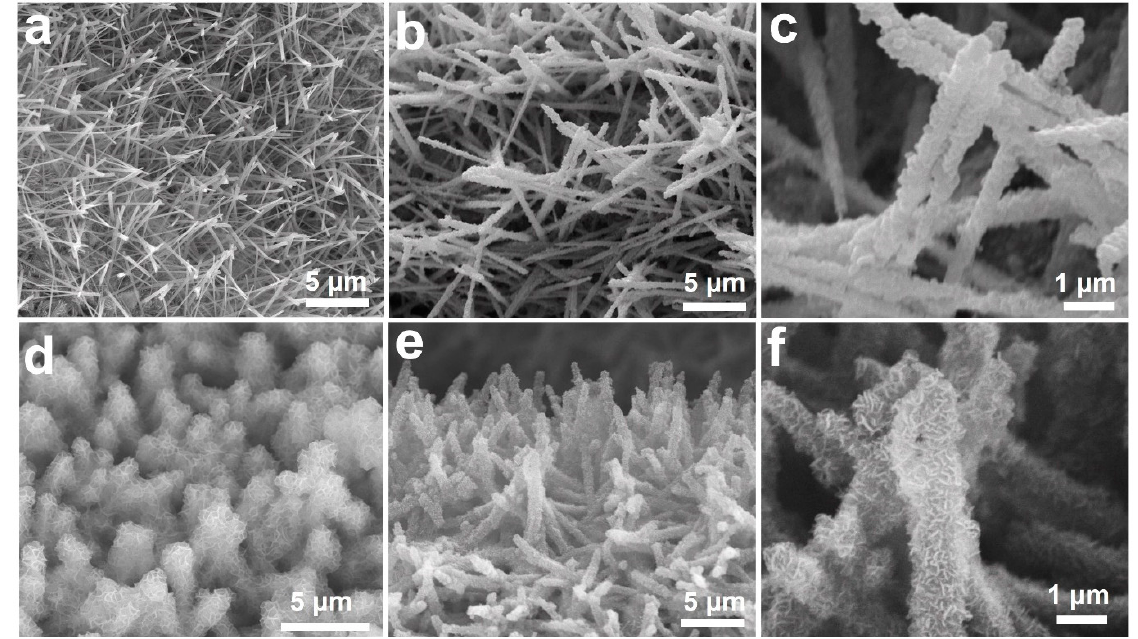
Figure 2. SEM images ( a – f ) of Cu(OH) 2 NAs ( a ), ZIF-8 modified Cu(OH) 2 NAs ( b , c ), Zn-Cu-Ni LDH ( d ), and ZnCuNiO x NAs ( e , f ).